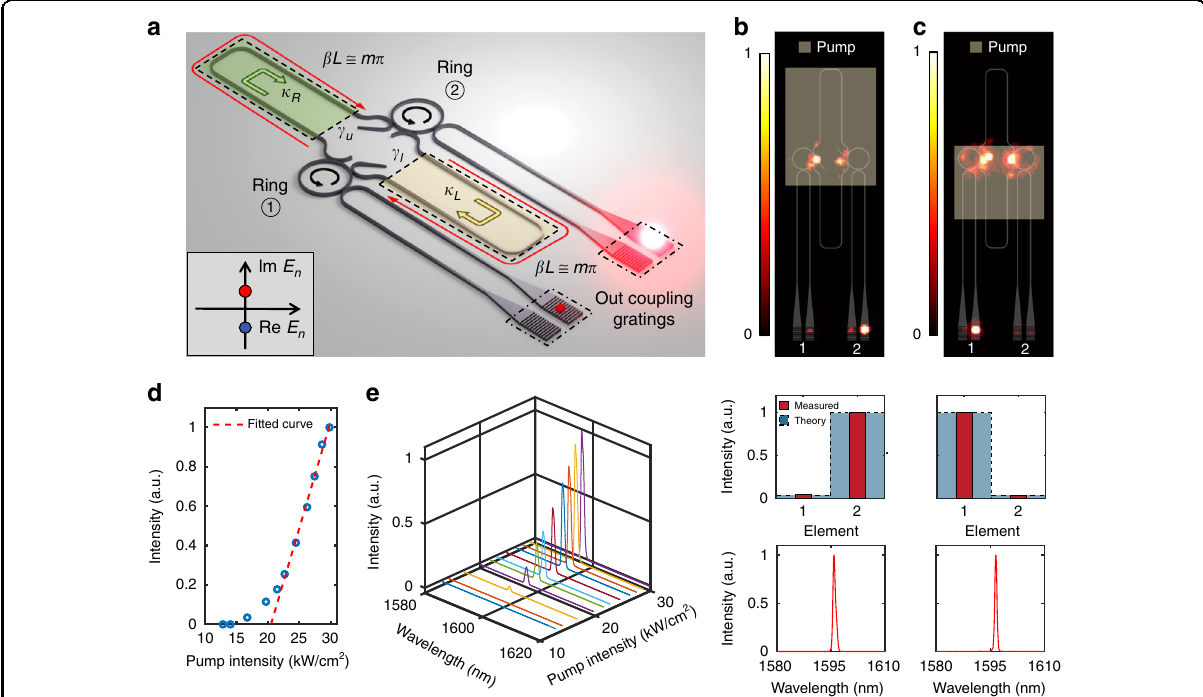
Fig. 2 Hatano – Nelson microring laser – 2-element system. a Schematic of the unidirectional microring laser with adjustable asymmetric coupling. Lasing in the counter-clockwise direction in each microring is promoted by properly terminating the link structure as to minimize the feedback to the clockwise mode. The magnitudes of the coupling coef fi cients depend on the pumping pro fi les of the upper and lower links, γ γ , respectively. The length of the links is set to satisfy β L ffi m π . Inset, the eigenvalues of the system become imaginary when the phase of the l coupling regions is set at β L ffi m π . In a laser system, the mode with the highest imaginary part eigenenergy (red circle in the fi gure) will reach lasing threshold fi rst and the laser array operates in a single-mode manner. b , c Emission pro fi les and spectra of the asymmetrically coupled two-resonator system. Under two different pumping pro fi les, the non-Hermitian skin effect appears towards two different directions (right and left). The number of data points in both spectra is 432. d , e Light – light curve and spectrum evolution of the laser system when it is operating as in ( b ). The resolution of the spectrometer is 0.64